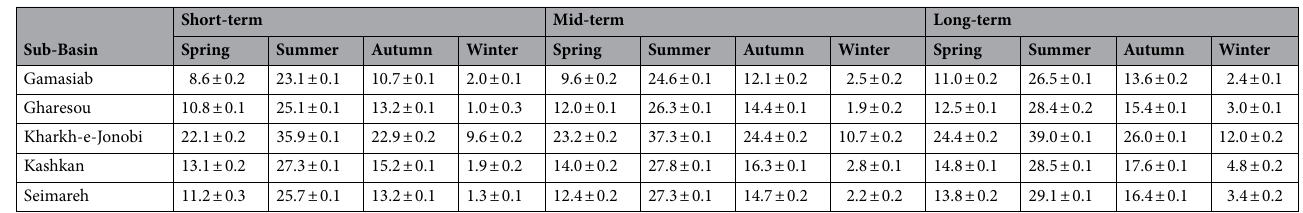
Table 2. The variation in the computed μ of the temperature’ posterior pdf s. The recorded values are within a 95% confidence